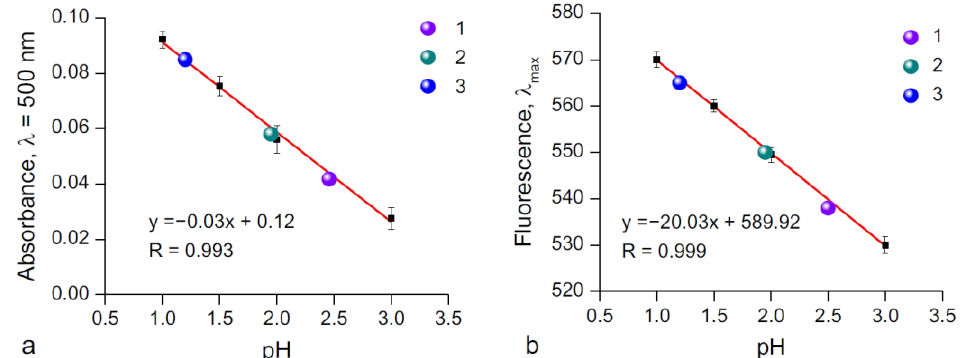
Figure 8. Dependence of the absorption intensity ( a ) and fluorescence λ max ( b ) on pH value for 30-layer LS film of QC8 transferred onto quartz substrate at 20 mN m − 1 : lemon juice pH 2.45 ( 1 ), lime juice pH 1.95 ( 2 ), and kefir whey pH 1.20 ( 3 ), λ ex = 420 nm. The error bars represent the standard deviation based on three measurements.